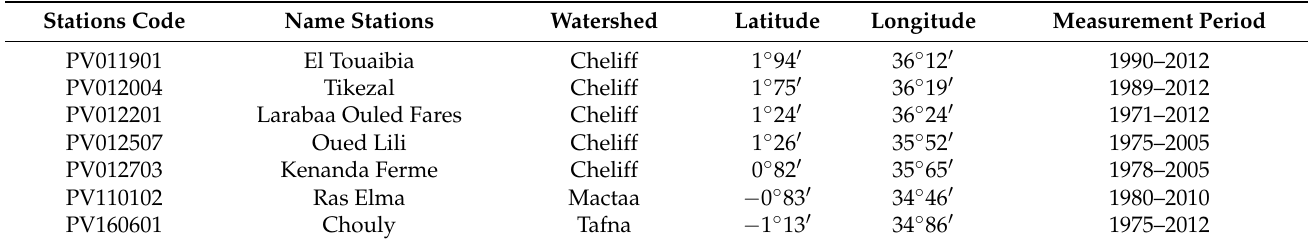
Table 1. Rainfall stations from the National Agency ANRH.